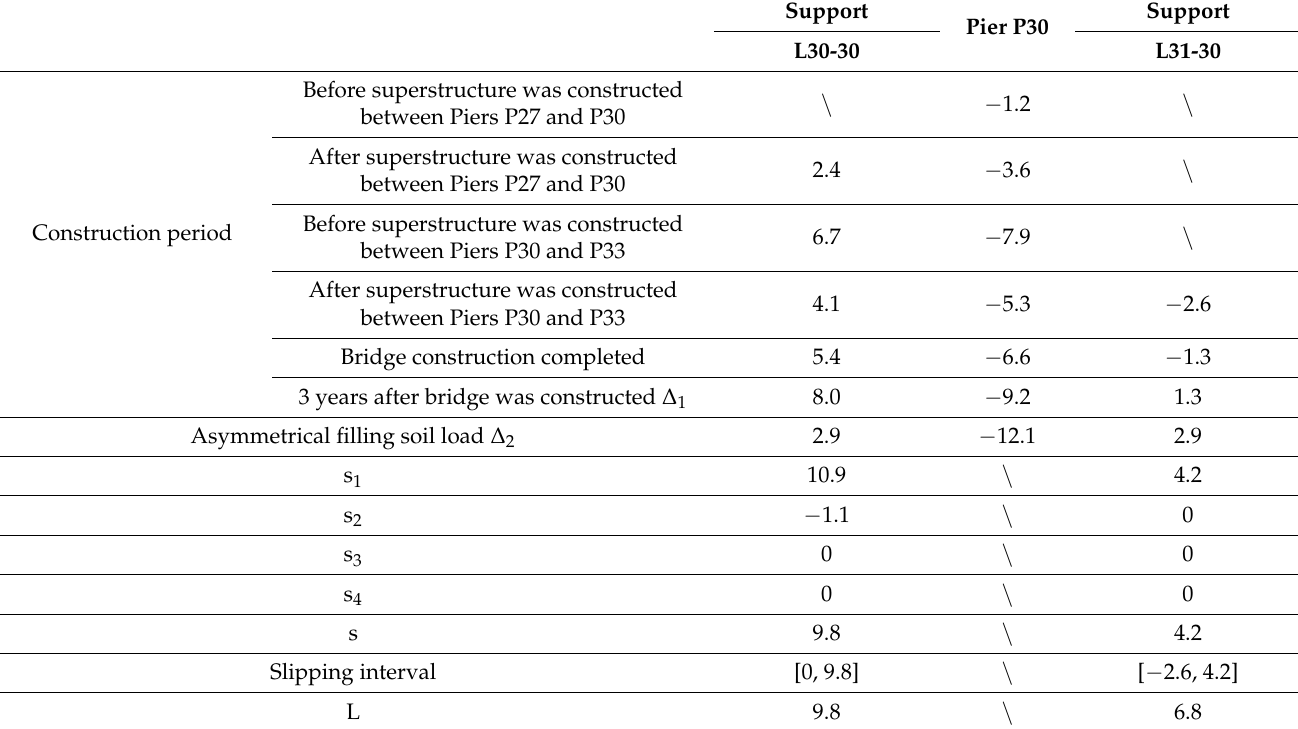
Table 4. Calculated inclination and support slipping of Pier P30 at different stages (cm).